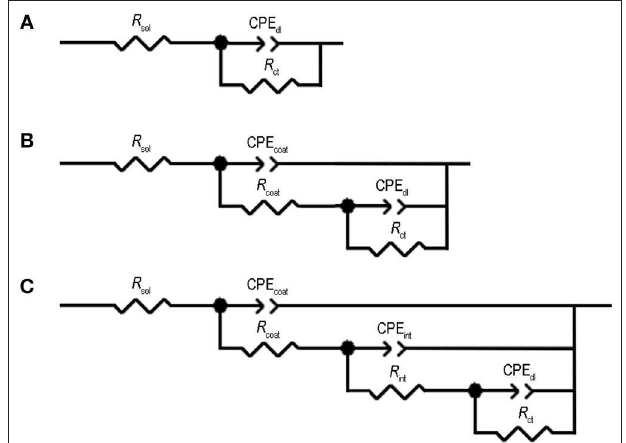
FIGURE 7 | Equivalent circuits used for numerical simulation of the EIS data for the Epoxy-PBA-CSmc and Epoxy-CSmc coatings: (A) equivalent circuit with 3 elements, (B) equivalent circuit with 5 elements, and (C) equivalent circuit with 7 elements.